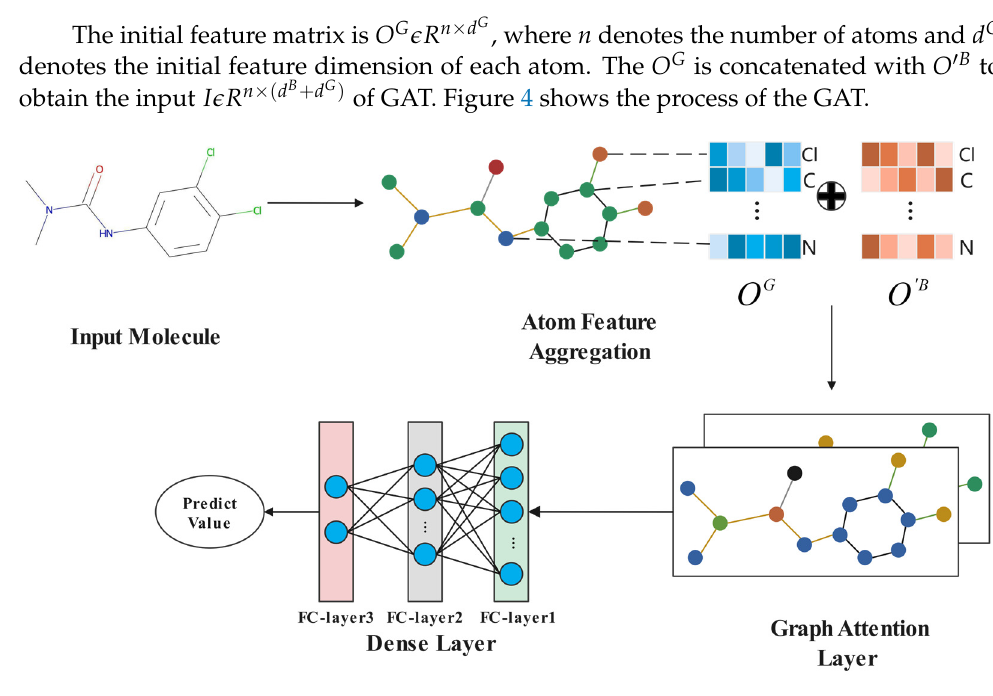
Figure 4. The process of GAT.